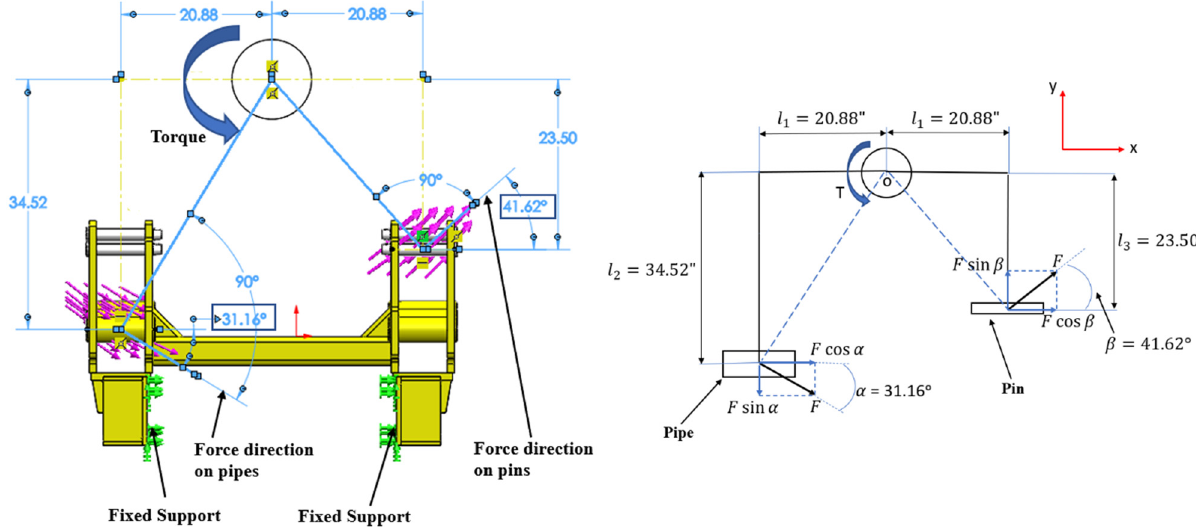
Figure 3: Load diagrams and parameters used to compute the equivalent loads for input torque. The 30,000 lb - ft of torque is translated into forces at the respective